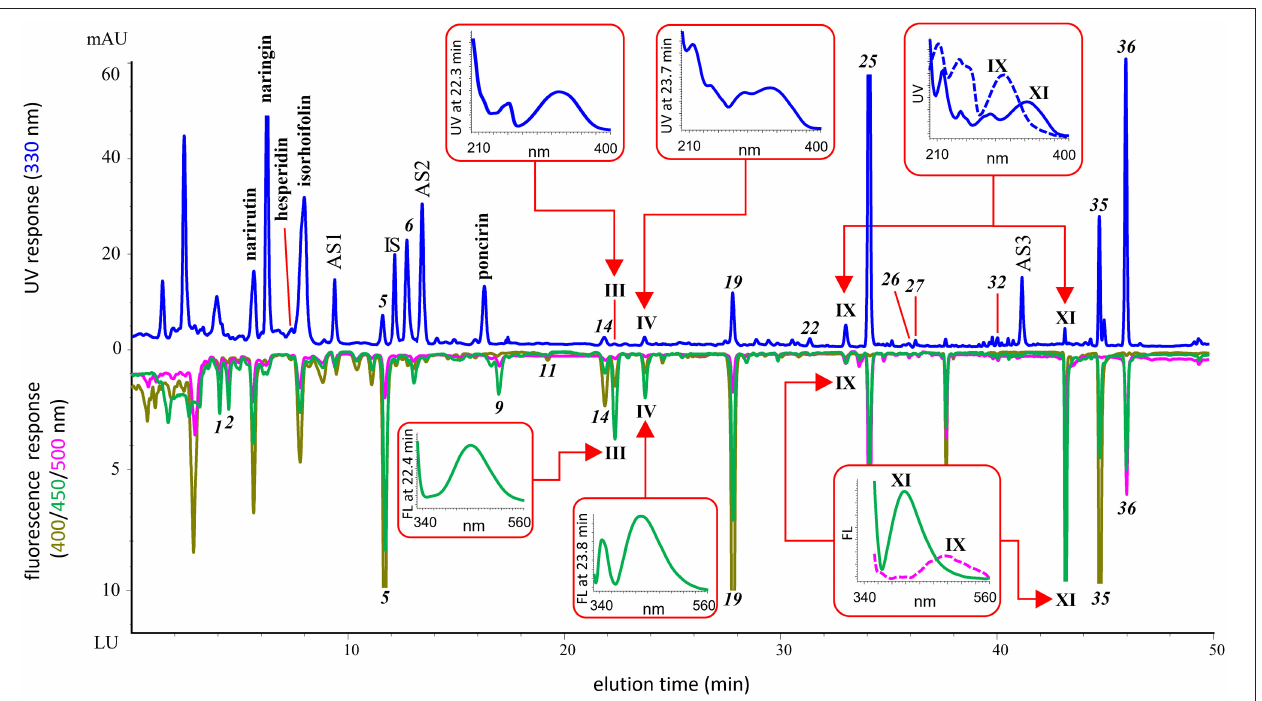
FIGURE 2 | Chromatograms of identified OHAs, tentatively identified OHA candidates and other major components in Thompson grapefruit juice. Showing the UV and fluorescence spectra of the tentatively identified OHAs.